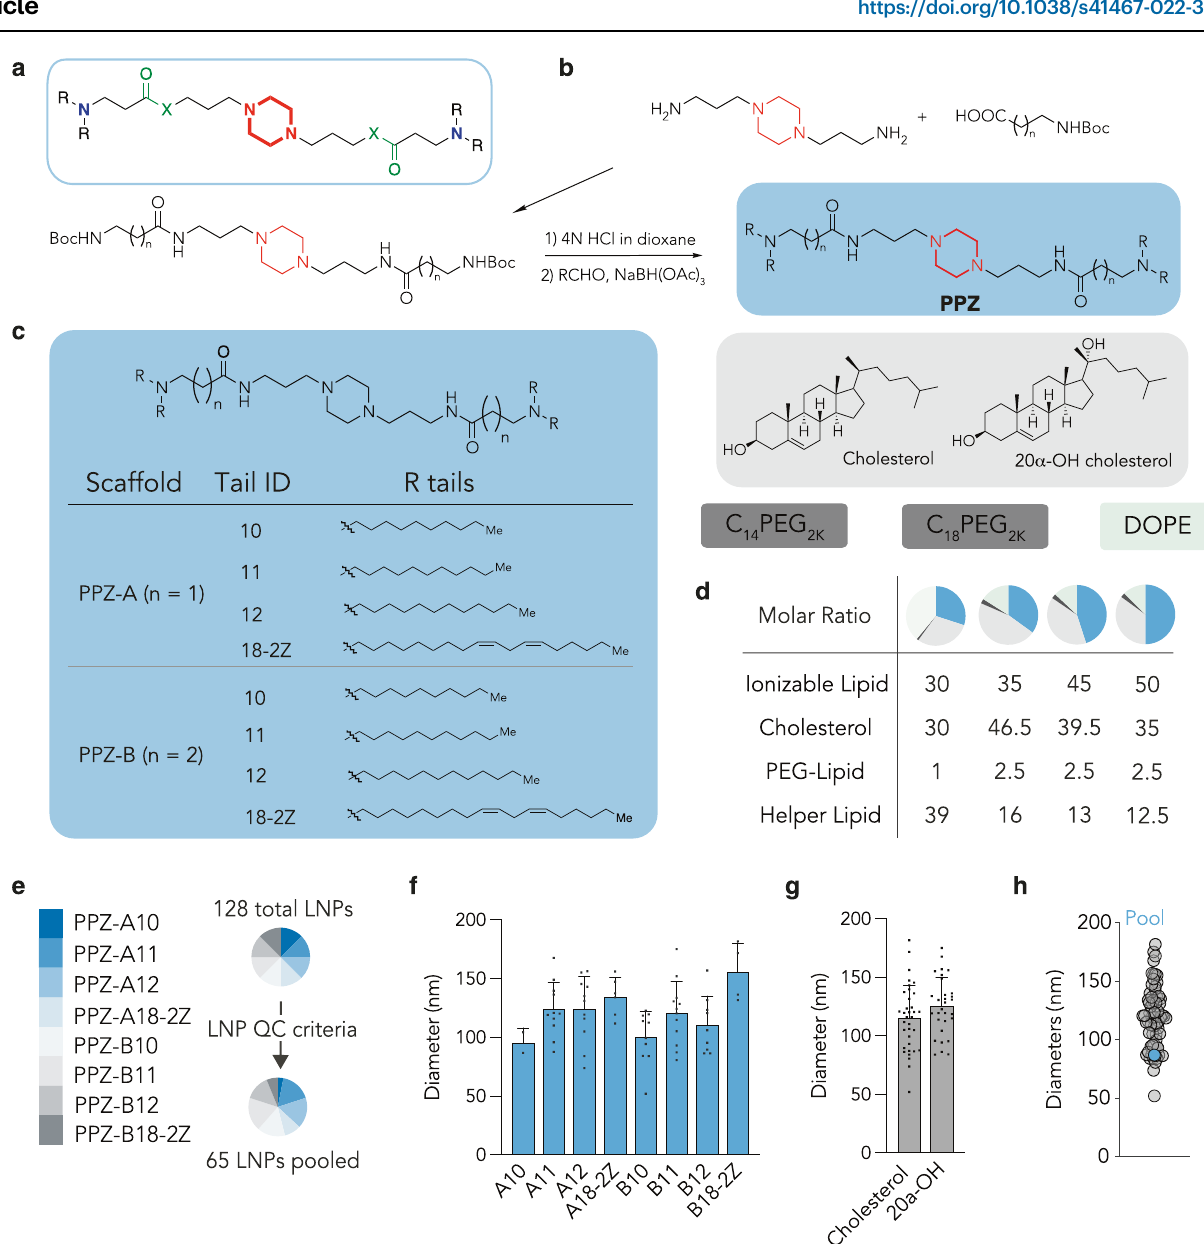
criteria,with a diameter less than200nm aswellasa stableautocorrelation curve. f Hydrodynamic diameters of LNPs formulated with PPZ lipids, average±SEM. g Hydrodynamic diameters of LNPs formulated with cholesterol and 20 α -OH cholesterol, average±SEM. h Hydrodynamic diameters of all administered LNPs; the diameter of the LNP pooled control iswithin the range of the LNPs composing the